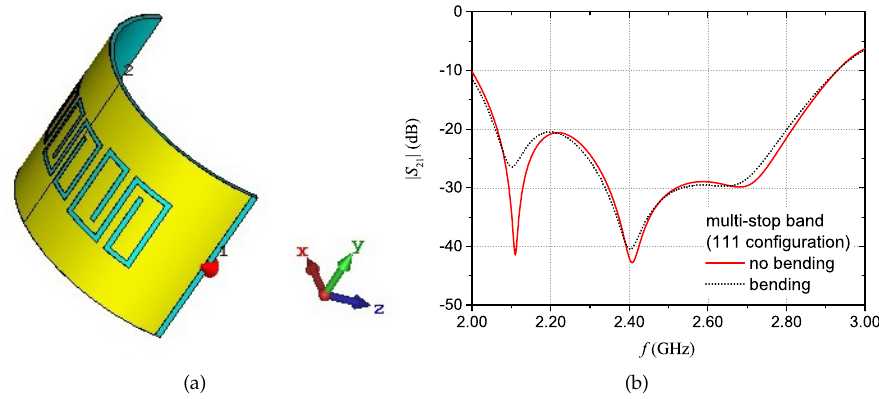
Figure 13. Multi-stopband structure: curved configuration ( a ) and simulation results of the magnitude of the S 21 with “bending” and with “no bending” of the structure ( b